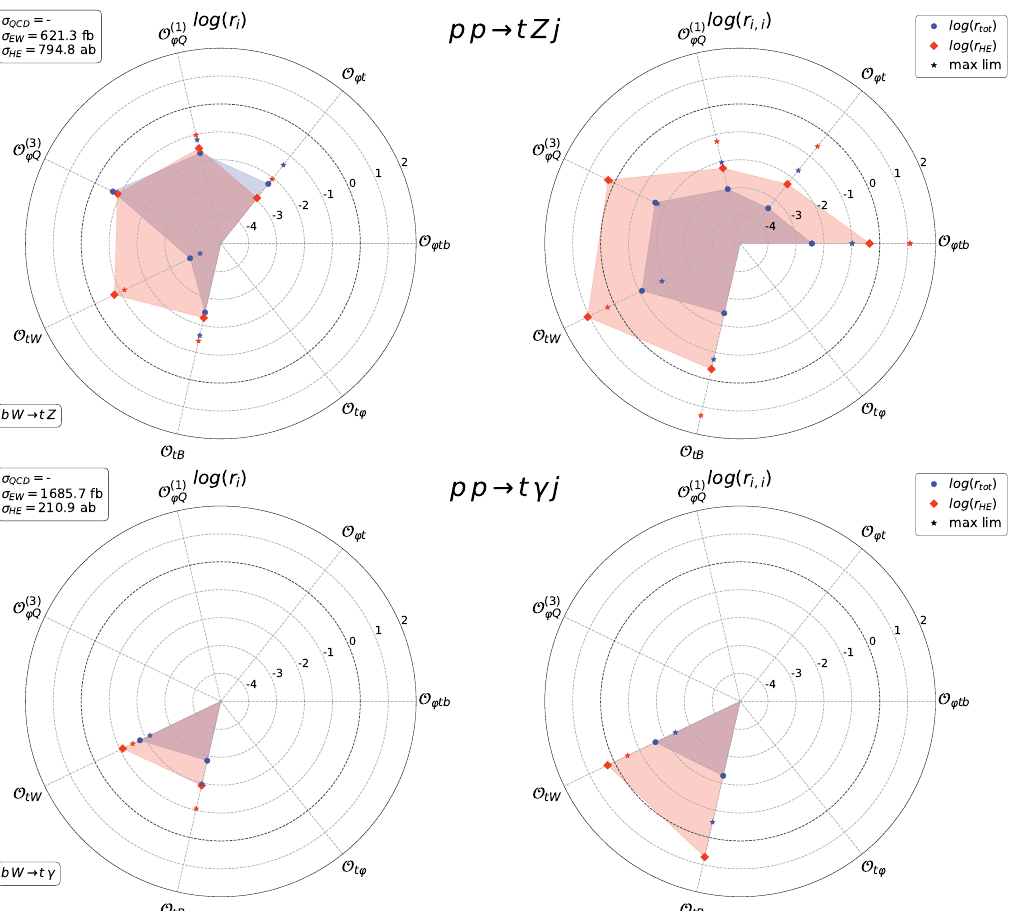
Figure 9. Radar plots for the p p and section 4.1.2 of the main text for a detailed